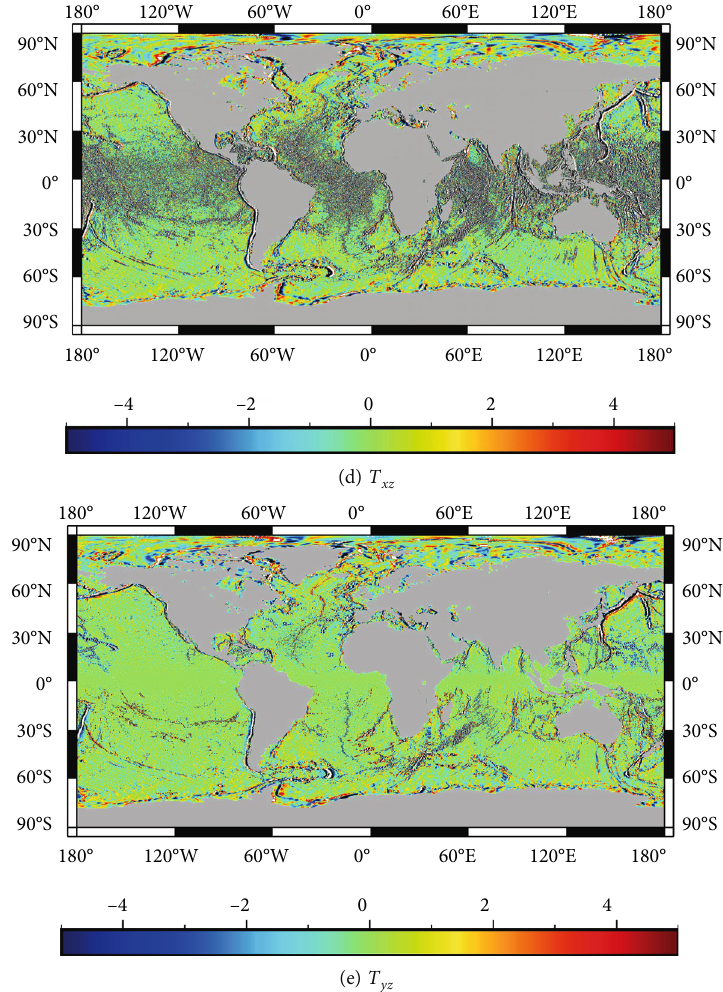
Figure 13: Global hexagonal ocean gravity gradient reference map model.